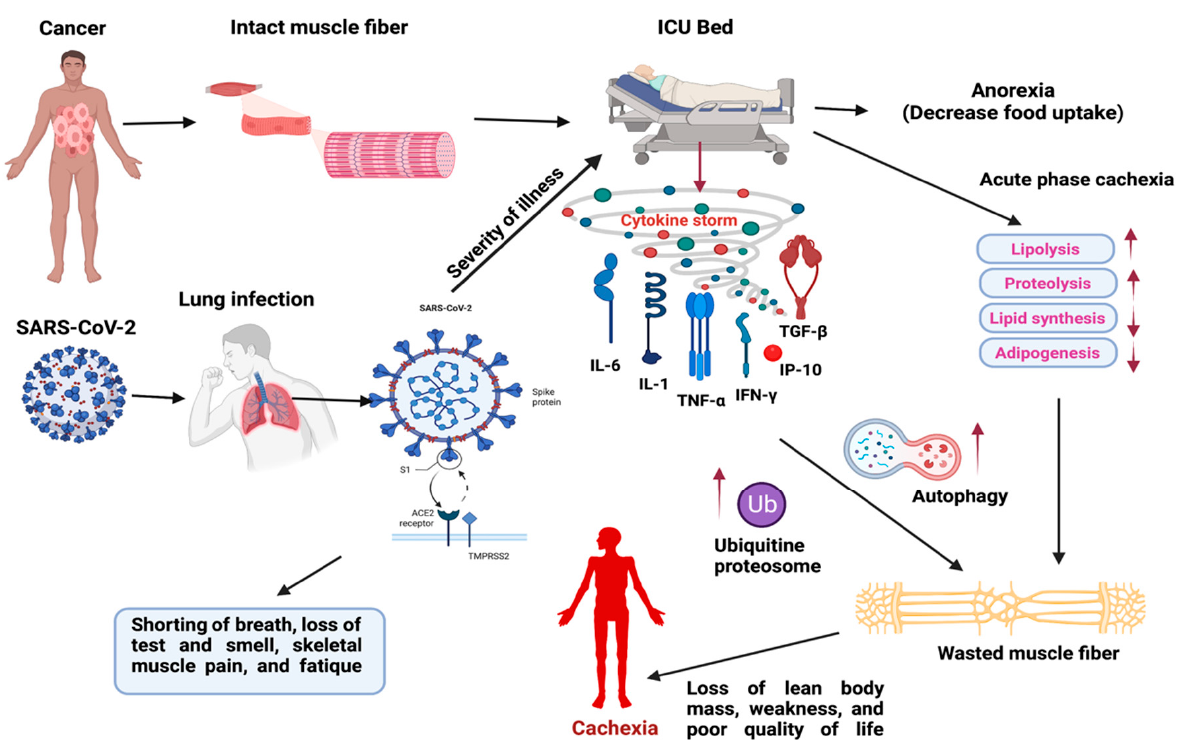
Figure 1. Representative model displays the effect of cytokine storm in cancer or COVID-19-related cachexia. Physical inactivity increases systemic inflammation in hospitalized cancer or COVID-19 patients. Increased levels of these cytokines (IL-1, IL-6, TNF- α , IFN- γ , IP-10, TGF- β ) impair hypothalamic appetite control and cause anorexia. At the same time, the ubiquitin-proteasome or autophagy triggered by pro-inflammatory mediators or proteins exacerbates muscle degeneration. Furthermore, during the acute phase of cachexia, adipose tissue is lost either by increased lipolysis or decreased lipid synthesis or adipogenesis. As a result, patients with infrequent skeletal muscle contractions feel tiredness, weakness, and a lower quality of life. (Created with BioRender.com).